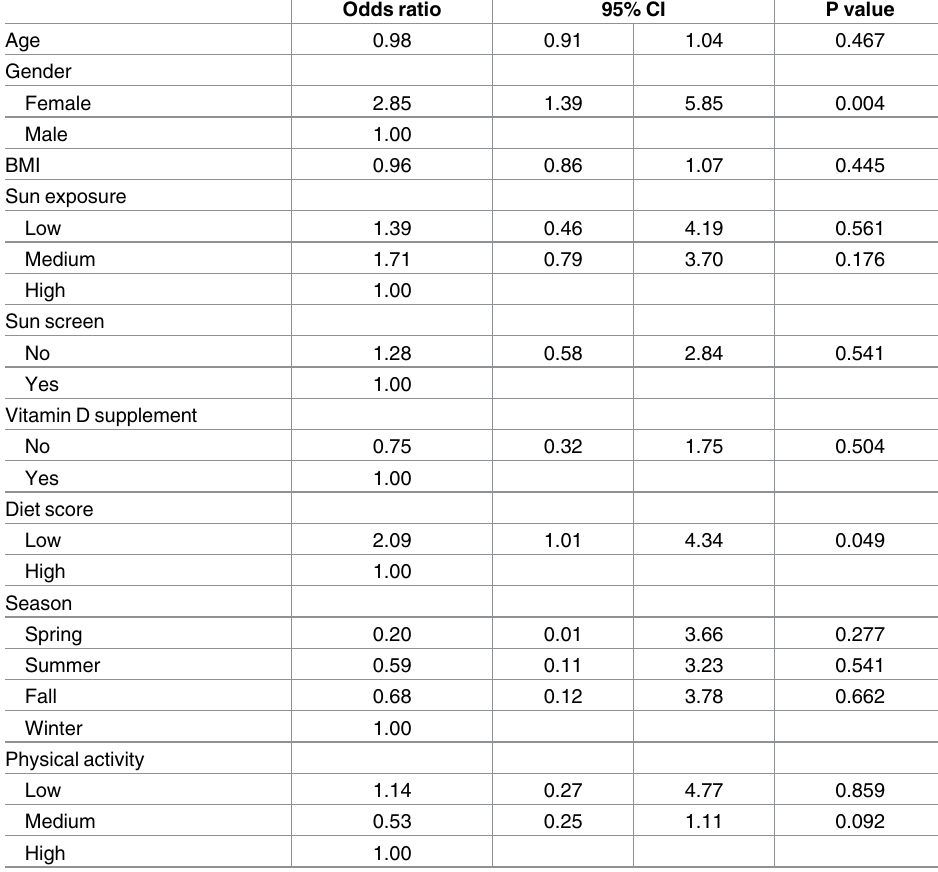
Table 2. Logistic regression for risk factors of low vitamin D